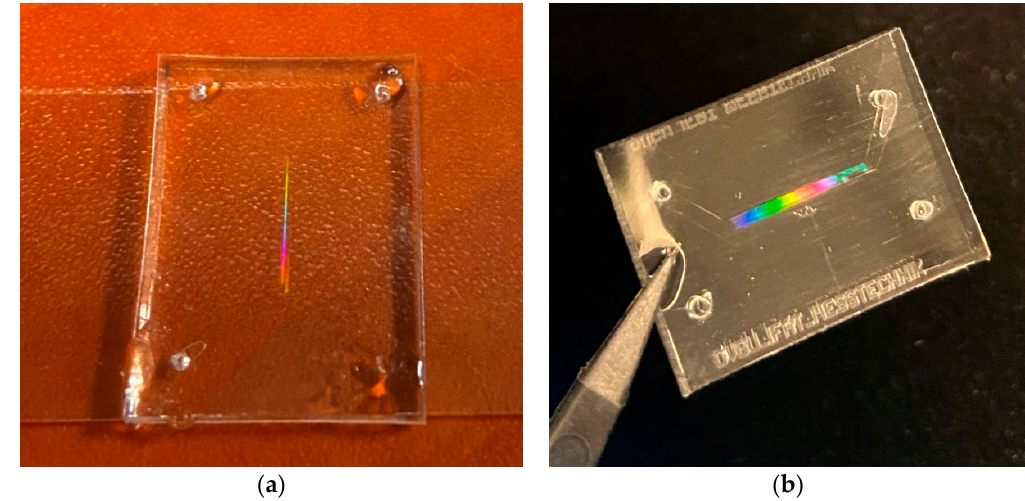
Figure 8. Separation of incident visible light by diffraction grating into separate colors from the fabricated PDMS structure with the 1 cm long, 100 µm ( a ) and 1mm ( b ) wide channels with micro-fabricated membranes.